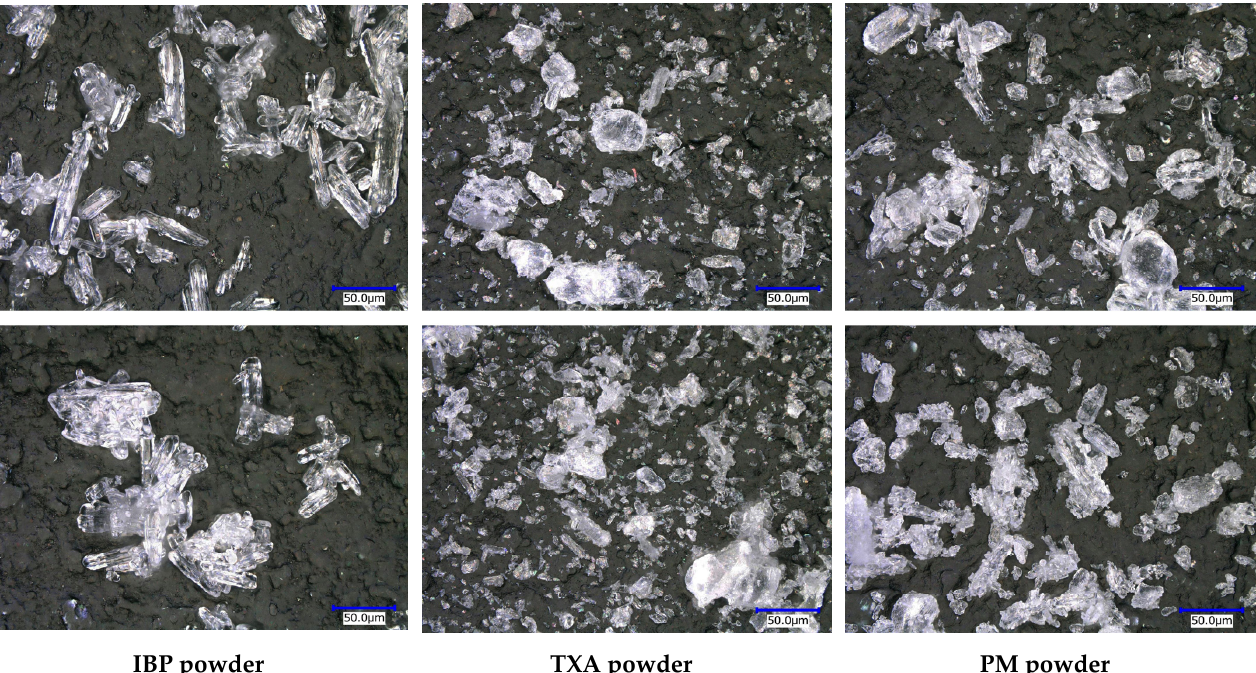
Figure 3. Crystal morphology of the IBP powder, TXA powder, and PM powder before ( above ) and after ( below ) storage at 50 °C for 60 days.